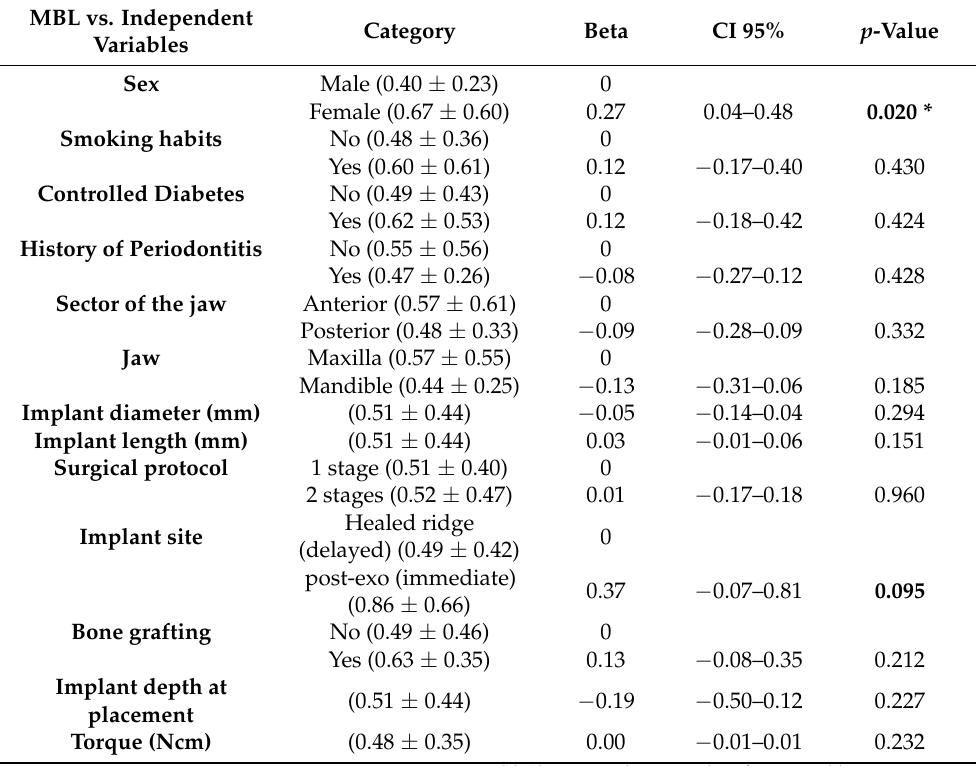
Table 4. Association between total MBL vs. independent covariates for patient profile, surgical protocol, and implant